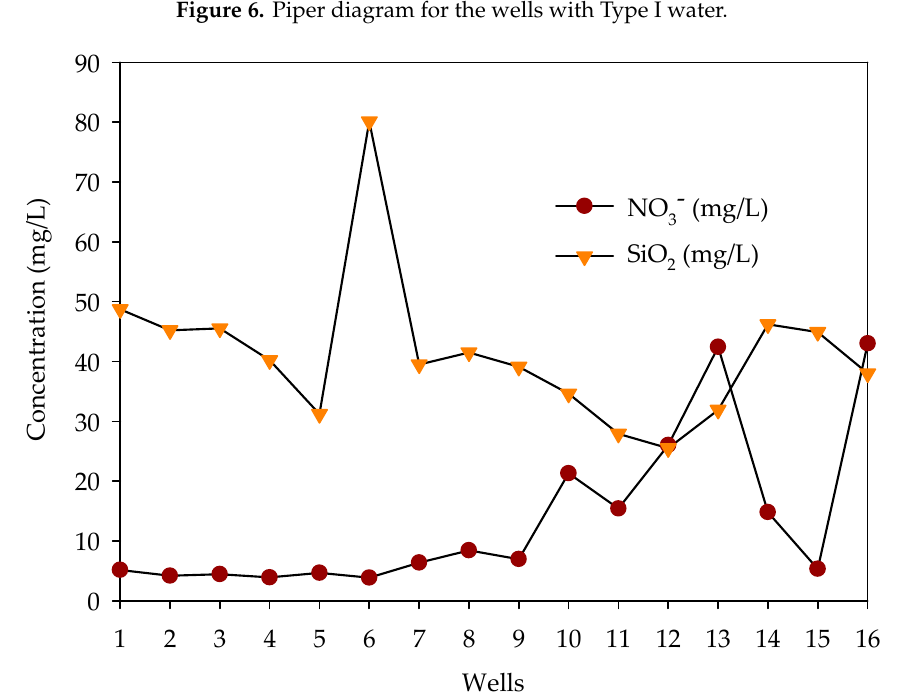
Figure 6. Piper diagram for the wells with Type I water.